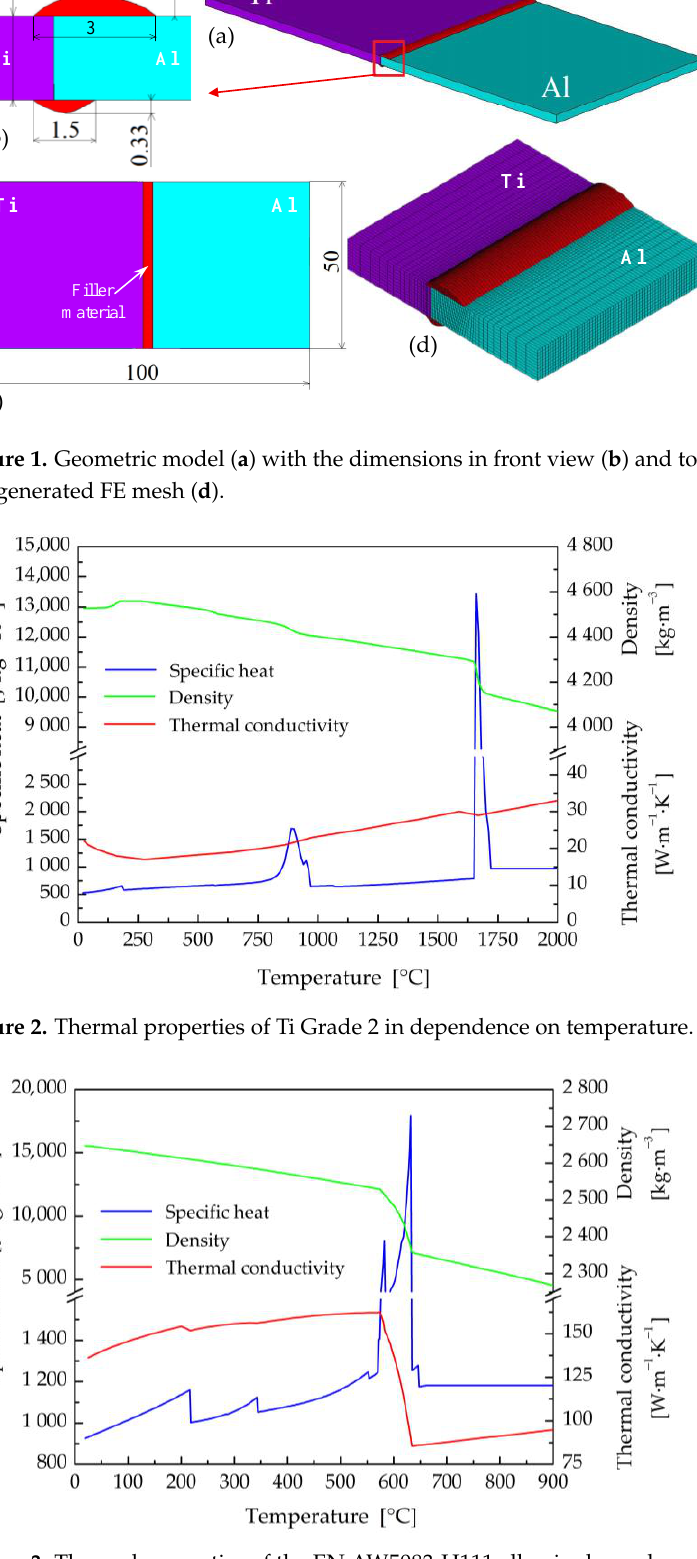
Figure 1. Geometric model ( a ) with the dimensions in front view ( b ) and top view ( c ) and a detail of the generated FE mesh ( d ).